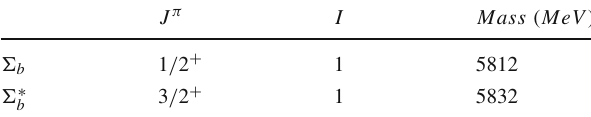
Fig. 1 Diagrams to be considered in the π(cid:2) b interaction Table 1 Resonances considered in π(cid:2) b